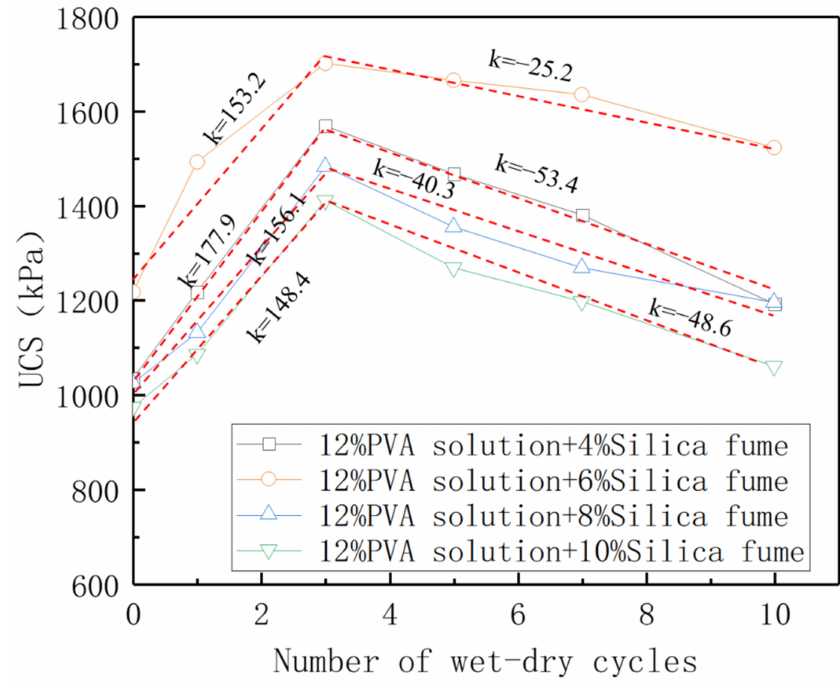
Figure 11. Change curve of UCS with number of wet–dry